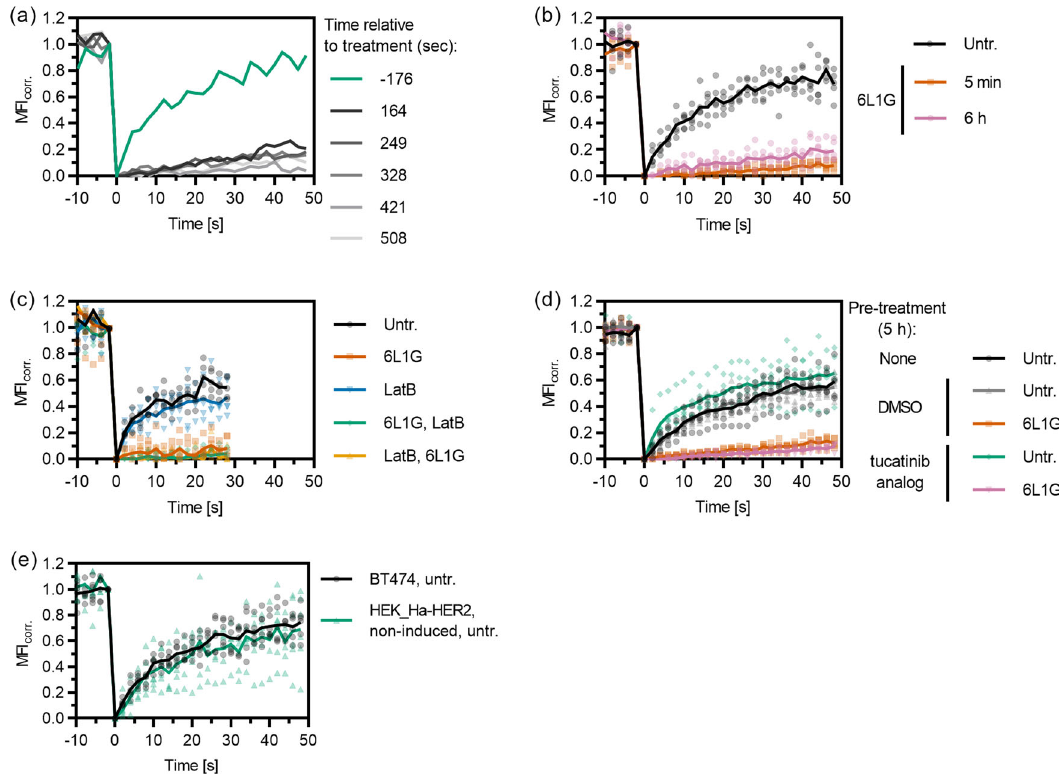
Fig. 5 Immediate and sustained immobilization of HER2 (labeled by the af fi body ZHER2) on the surface of BT-474 cells is mediated through DARPin – receptor interactions. a Individual FRAP curves (no averaging) before and after addition of DARPin 6L1G, colored according to the starting time relative to DARPin addition, show immediate immobilization. b HER2 immobilization is similar after 5 min and 6 h of treatment. c FRAP experiments in cells treated with Latrunculin B in the absence of DARPins (LatB), and cells treated with LatB before (LatB, 6L1G) or after (6L1G, LatB) bipDARPin addition indicate that cytoskeleton interactions are not directly involved in HER2 immobilization upon DARPin treatment. d Pre-treatment with a HER2-speci fi c HER2 kinase inhibitor (Selleckchem S2752, an analog of ARRY 380) does not affect immobilization, suggesting that immobilization is independent of HER2 kinase activation. e HER2 immobilization occurs at a wide range of expression levels, as indicated by FRAP measurements on HER2-overexpressing BT-474 cells and non-induced HEK cells stably transfected with HaloTagged HER2. Note that the sensitivity of the FRAP method limits the cell lines that can be investigated to those with at least intermediate expression levels (Supplementary Table 1 and Supplementary Fig. 2). Data for untreated cells (Untr.) and 6L1G in c are identical to those shown in Fig.